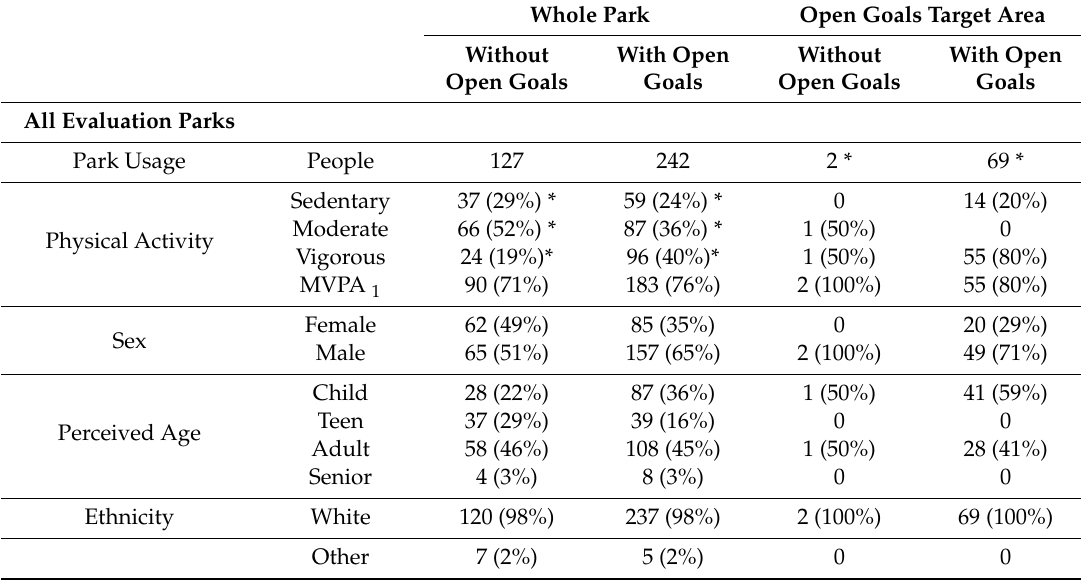
Table 4. System for Observing Play and Recreation in Communities (SOPARC) frequency demographics for park